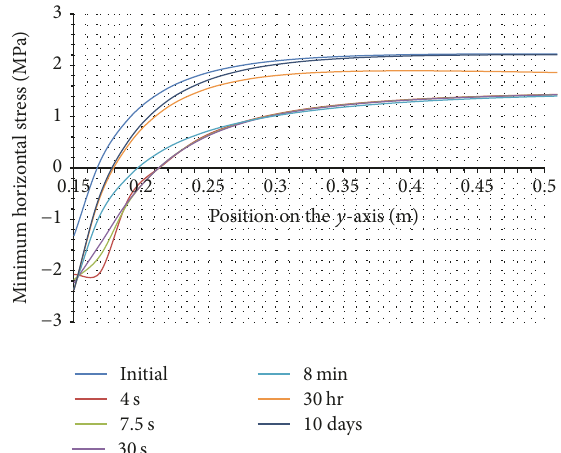
Figure 13: 𝑌 -component of minimum horizontal stresses as a function of time in poroelastic medium with 𝜎 𝐻 = 16.8 MPa and 𝜎 ℎ = 14MPa, 𝑃 𝑟 = 11MPa, 𝑃 𝑤 = 9.7 MPa, 𝑘 𝑥 = 0.01md, 𝑘 𝑦 = 0.01 md, and 𝑇 𝑚 = 330 K.